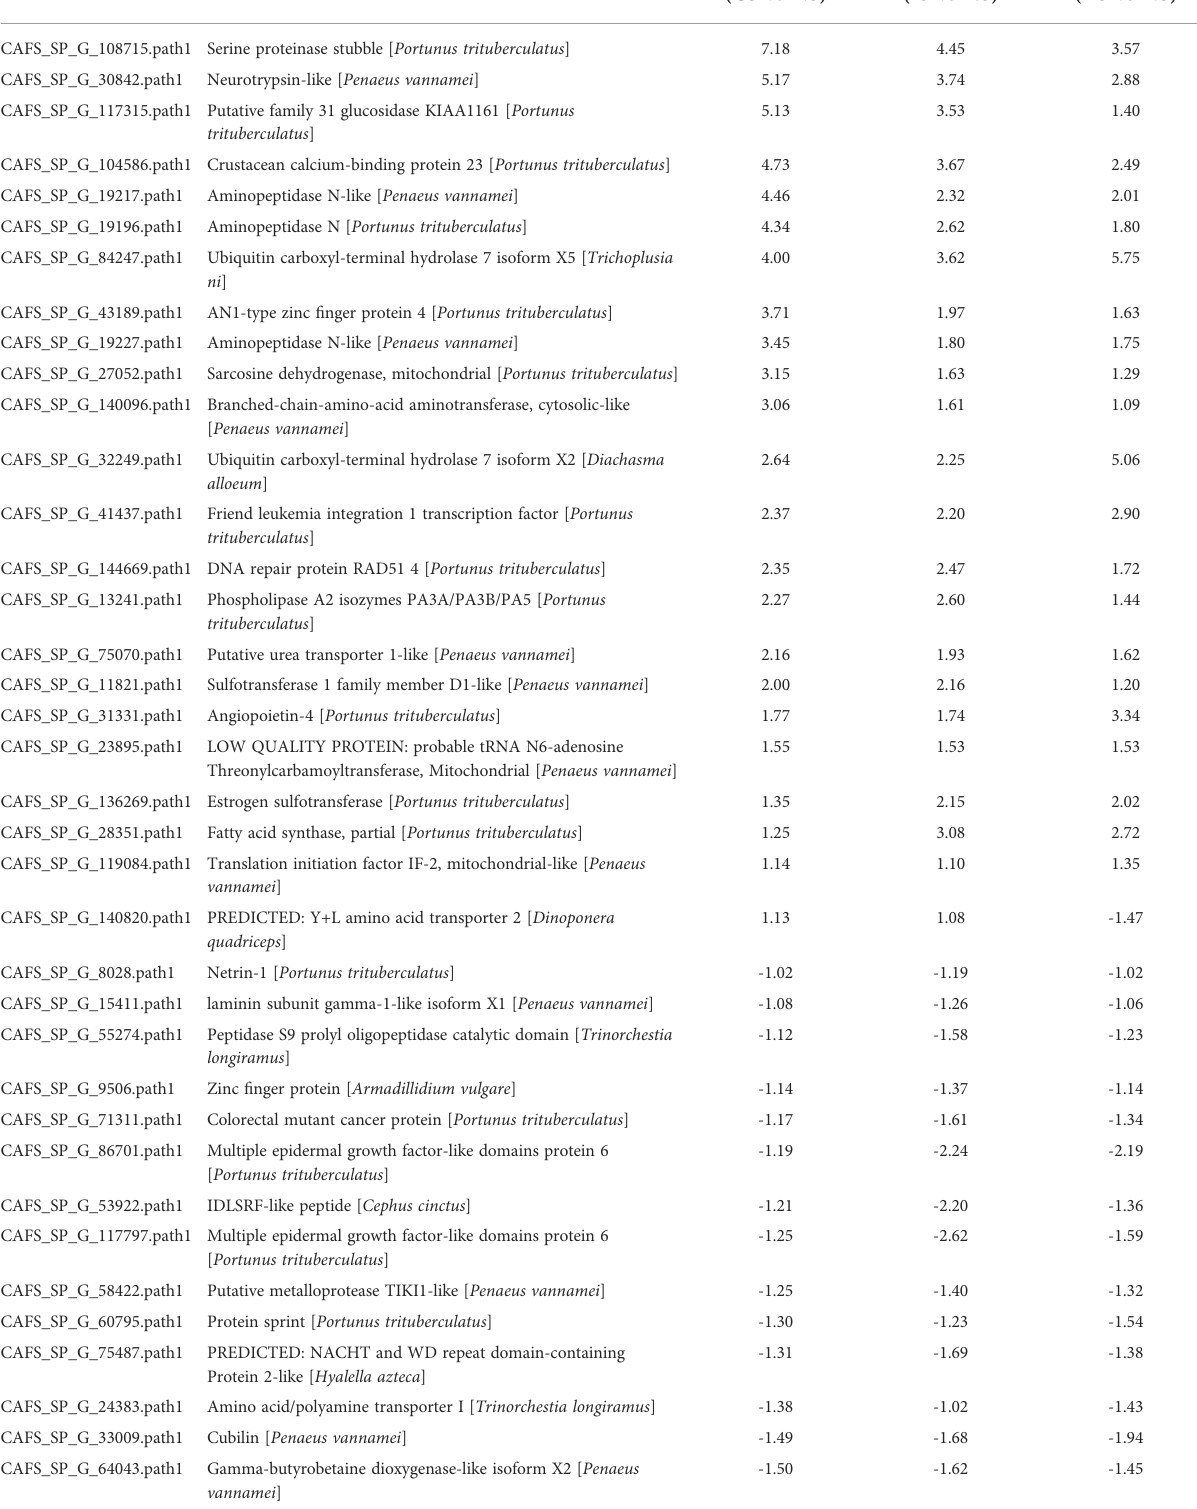
TABLE 2 Differentially expressed genes